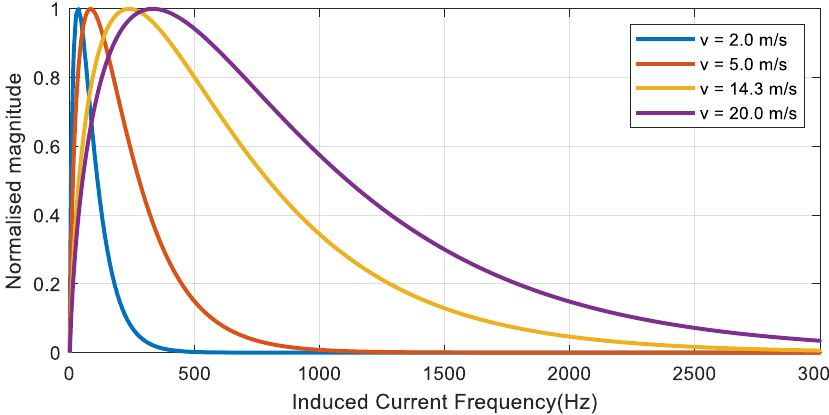
Figure 16. Spectrum analysis of the induced current under different moving speeds.